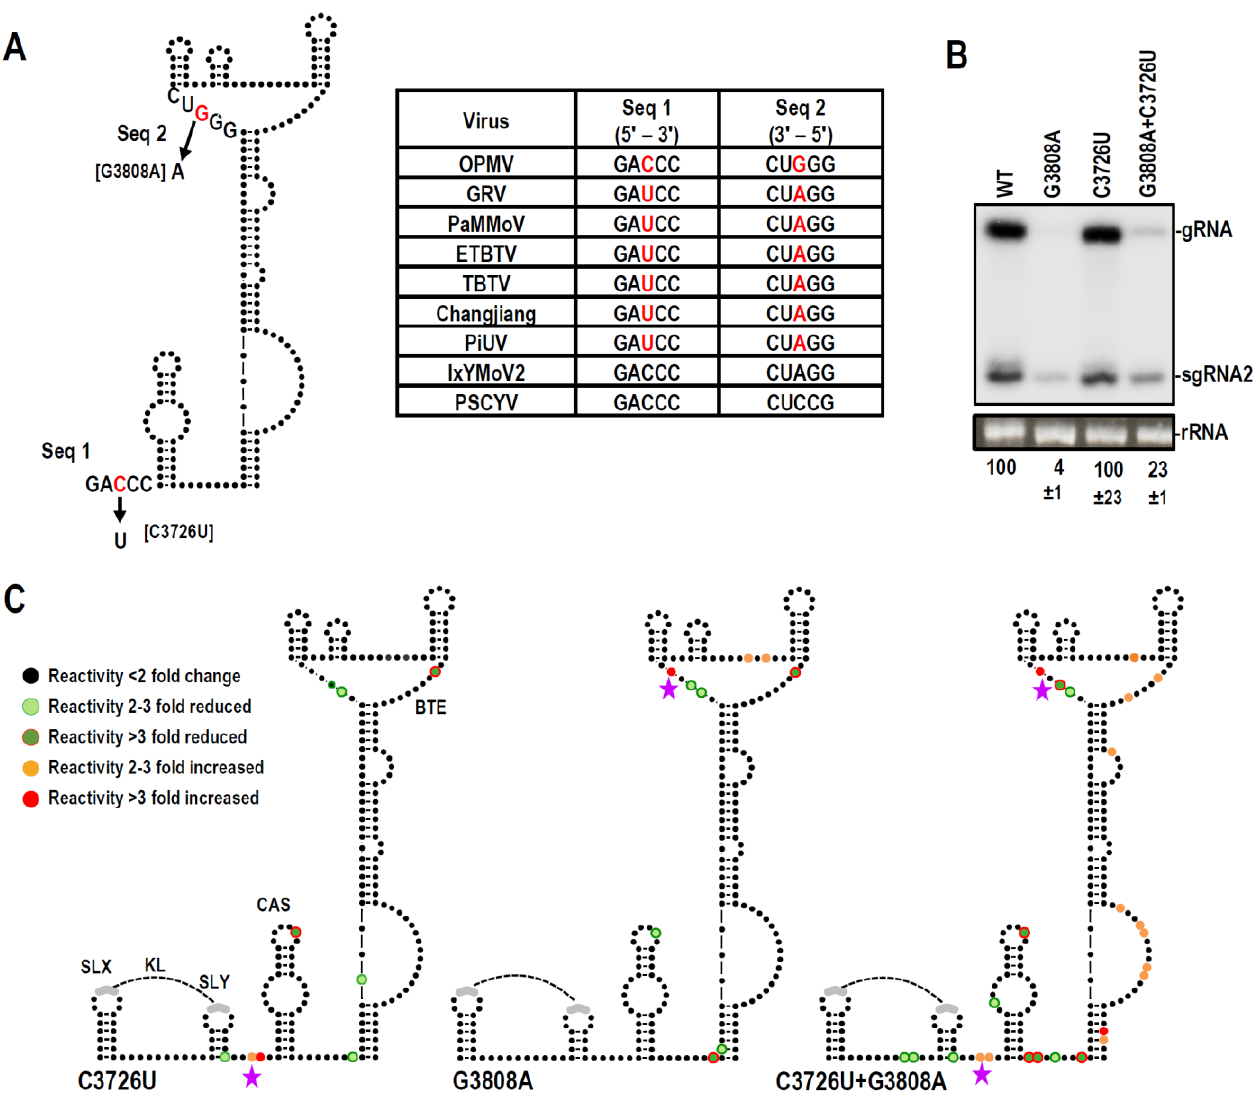
Figure 6. Direct interaction between CAS- and BTE-conserved sequences is not supported by SHAPE. ( A ). Location of the alterations and table showing conserved sequence just upstream of CAS that can potentially pair with conserved sequence in the BTE. OPMV contains a covariant change not present in other umbraviruses. ( B ). RNA gel blot analysis of total RNA extracted from systemically infected N. benthamiana following agroinfiltration with either WT OPMV or CAS/BTE mutants. Ethidium bromide-stained 26S rRNA was used as a loading control. Standard error is shown from three independent experiments. ( C ). SHAPE probing of OPMV gRNA mutants. Colors represent changes in nucleotides reactivity relative to WT. See legend to Figure 5. Star indicates location of alterations. SHAPE data were averaged from at least 3 independent replicates.